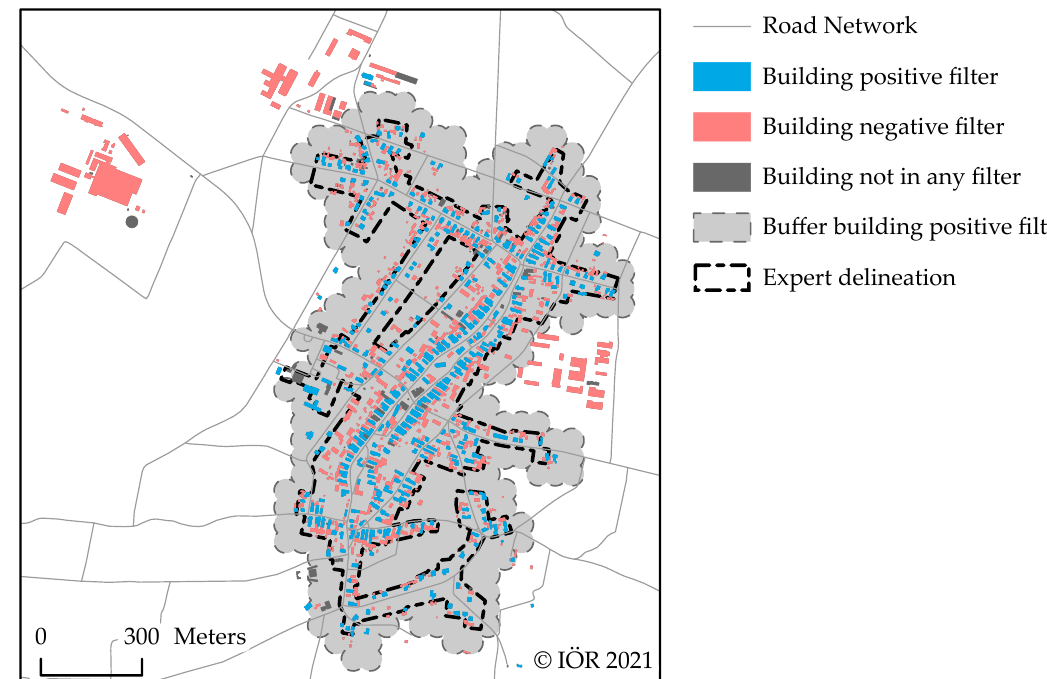
Figure 5. The figure shows how the filter algorithm works using the example of the settlement of Hirschfeld in Brandenburg. The buildings removed by the negative filter (highlighted in red) can be found both inside and outside the expert boundary. In contrast, the majority of the buildings of the positive filter (highlighted in blue) only occur within the expert boundary. Very few buildings remain unassigned to either of the two filters. The application of the density function ensures that not every single blue building contributes to the formation of the positive buffer polygon. The red buildings outside the buffer area are removed. The assignment was made on the basis of explicit statements in the commentary literature or the legal text of the BauGB. ( Source : own compilation based on data from official building polygons, ATKIS ® Base-DLM © Geobasis-DE/BKG